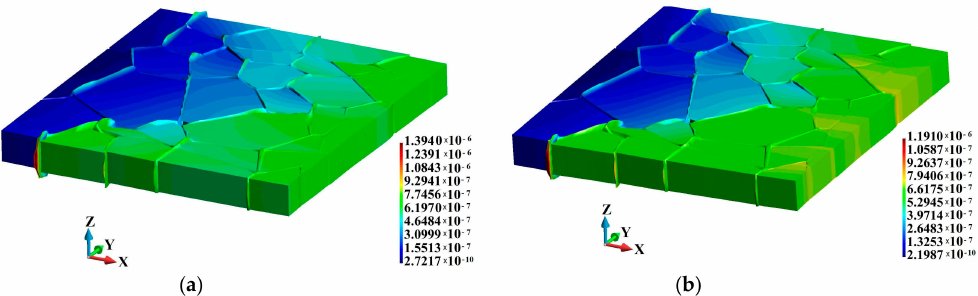
Figure 4. Displacement (m) fields (magnified 5 times): ( a ) Adiabatic solution; ( b ) coupled solution.